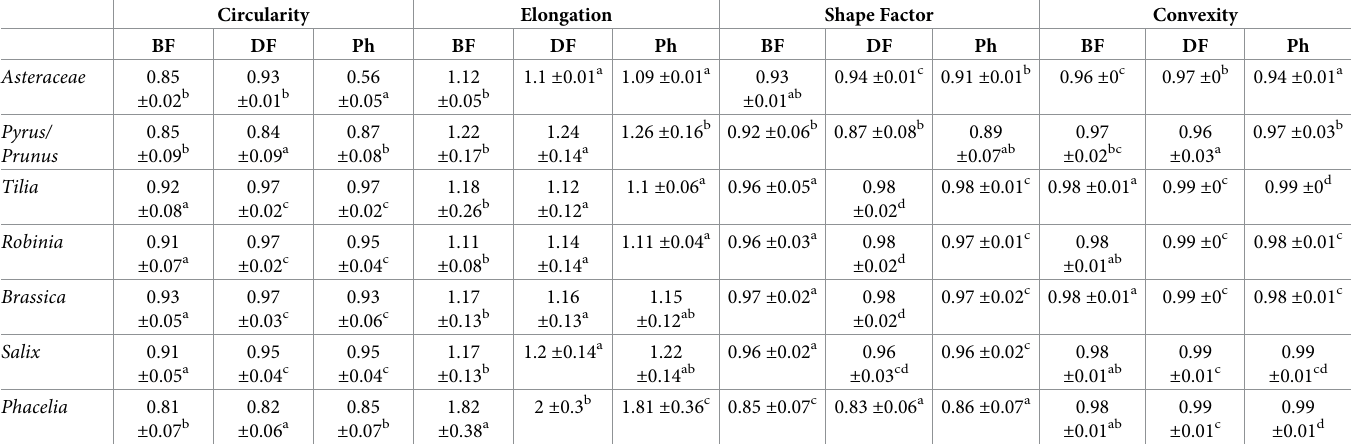
Different letter in the column indicates significant differences between taxa (p < 0.05).